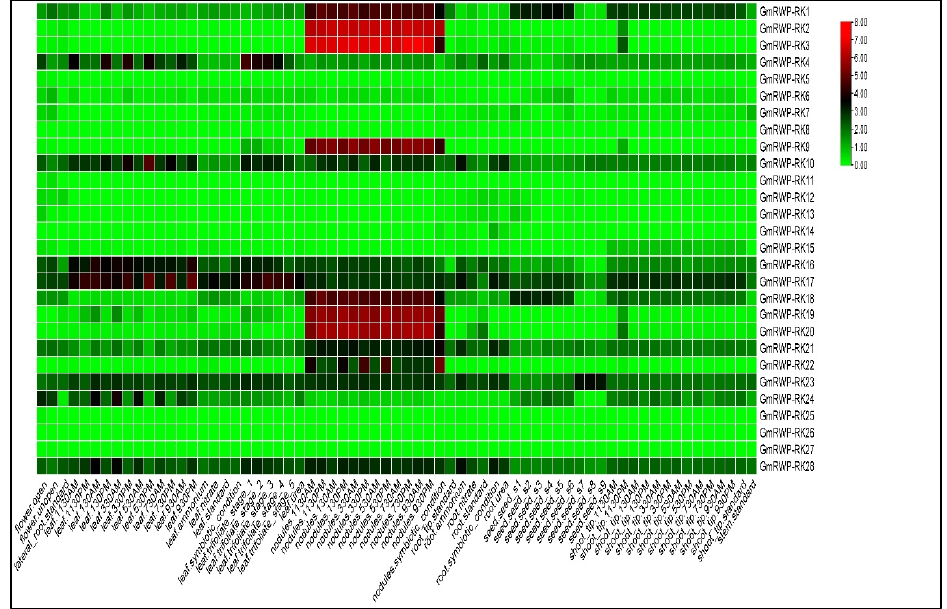
Figure 6. Expression analysis of GmRWP ‐ RK genes in different tissues (seed, nodule, root, leaf, shoots, and flowers) in soybean. The log2fold values of GmRWP ‐ RK genes with the corrected p ‐ values were used to construct the heatmap using TBtools software. The red and green colors in the heatmap represent the expression of GmRWP ‐ RK genes from bottom to top. 2.7. Expression analysis of RWP ‐ RK Genes Family under Phytophthora Sojae